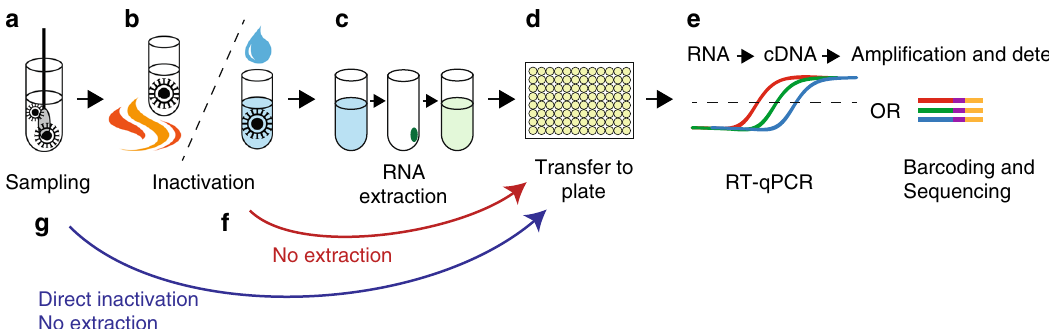
Fig. 1 Schematic overview of SARS-CoV-2 RT-PCR testing procedure. The currently widely used procedure for COVID-19 testing involves: a Collection of patient material and deposition of potential SARS-CoV-2 viral particles in transport medium. b Inactivation of the virus by detergent/chaotropic reagents or by heating. c RNA extraction. d , e Transfer to PCR-plate (96/384-well) format in which cDNA synthesis by RT and detection by qPCR may take place. Alternatively, detection can be made by sample barcoding and high-throughput DNA sequencing. f , g Unlike the widely used approach, which includes an RNA extraction step (c) using industrial RNA extraction kits, direct sample testing circumvents this process by omitting extraction. Instead, after clinical samples are deposited in transport medium, viral particles are inactivated either through heating or by direct lysis in detergent-containing buffer. The inactivated samples are then used for the downstream RT-PCR diagnostic